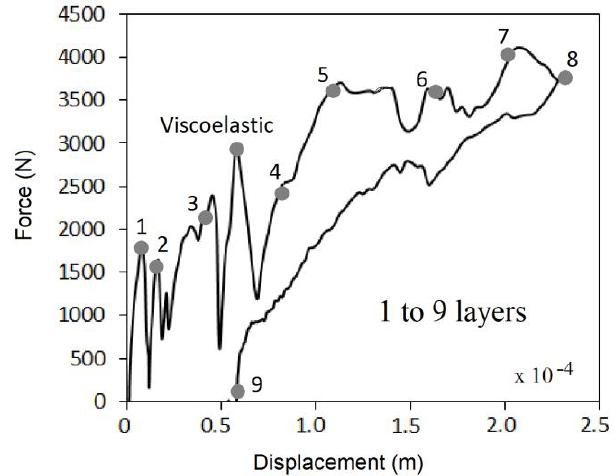
Figure 22. Comparison of the force vs. displacement diagram for an impact at 80 J in modified panel.